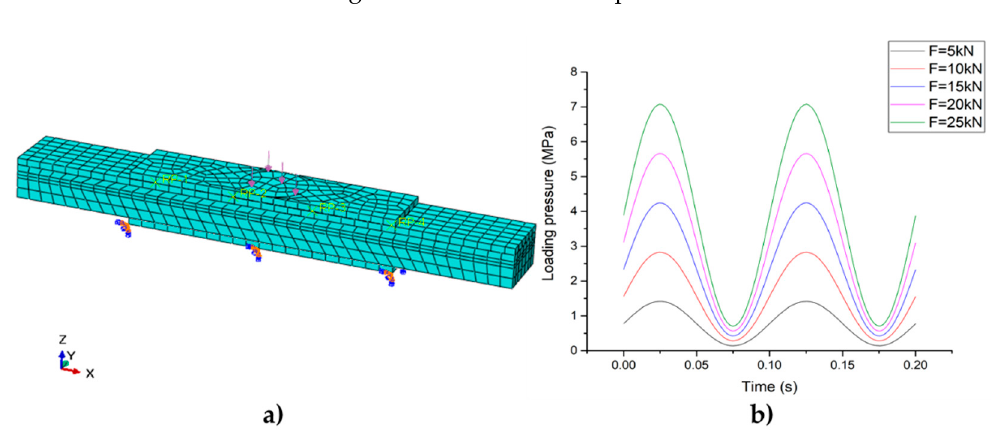
Figure 10. Linearly uniform loading. ( a ) Load and boundary conditions; ( b ) load curve.